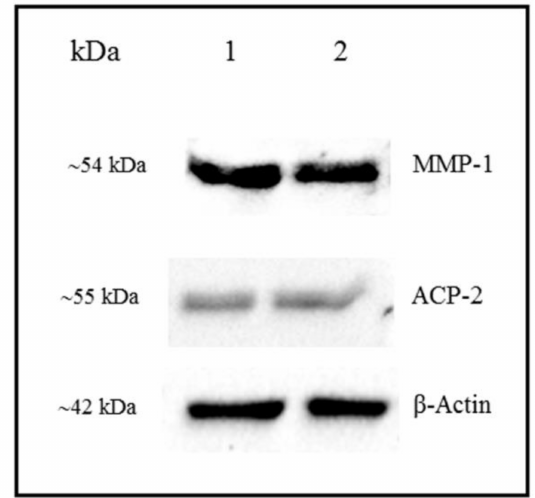
Figure 8. Western blot of MMP-1 and ACP-2 from extracts of oral mucosa of the eruptive pathway obtained from two 16-day-old rats. Bands at 54 kDa and 55 KDa levels, corresponding to MMP-1 and ACP-2 molecular weights, respectively, are observed. Actin bands (~42 KDa) are also